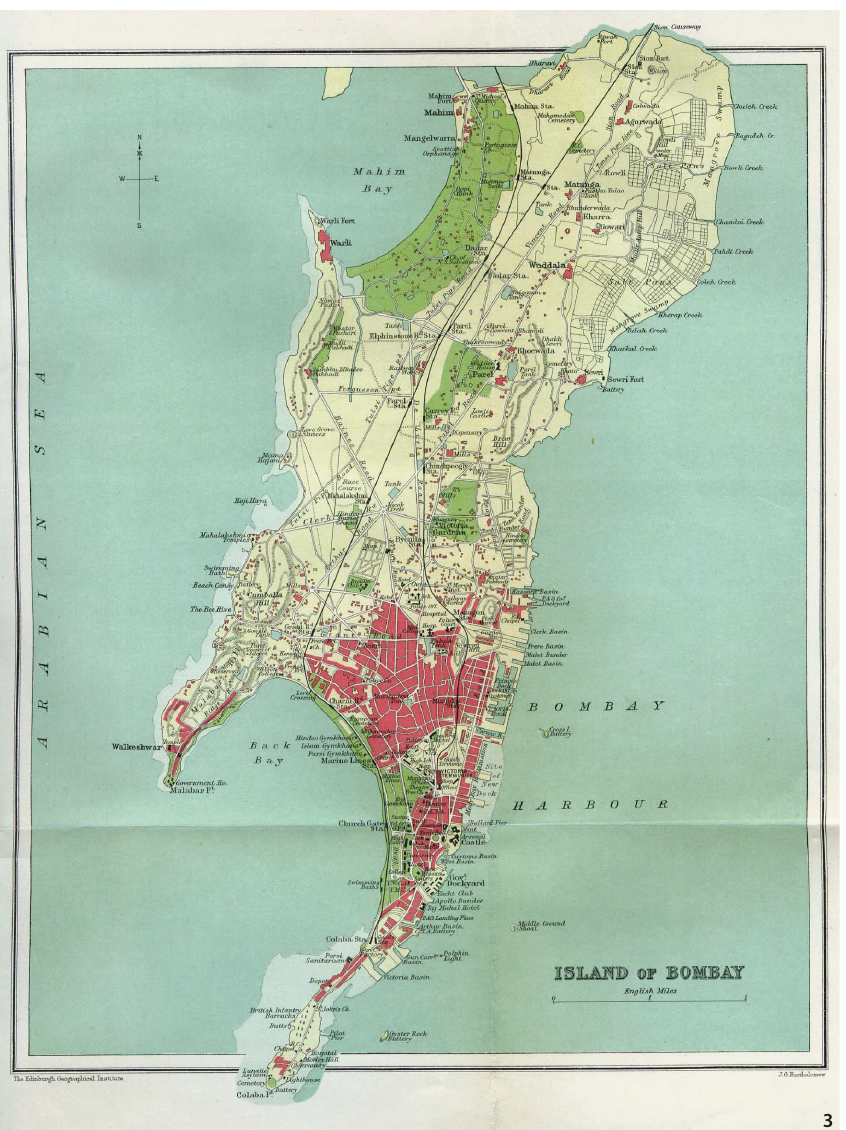
Figure 3 Map of Bombay/Mumbai, 1909. Mill districts are located in the central part of the map, on either side of the land where the two railway lines ran closely parallel to each other. (Source: The Gazet- teer of Bombay City and Island , Volume 1, 1909. Map author: J. G. Bartholomew, The Edinburgh Geographical Institute).